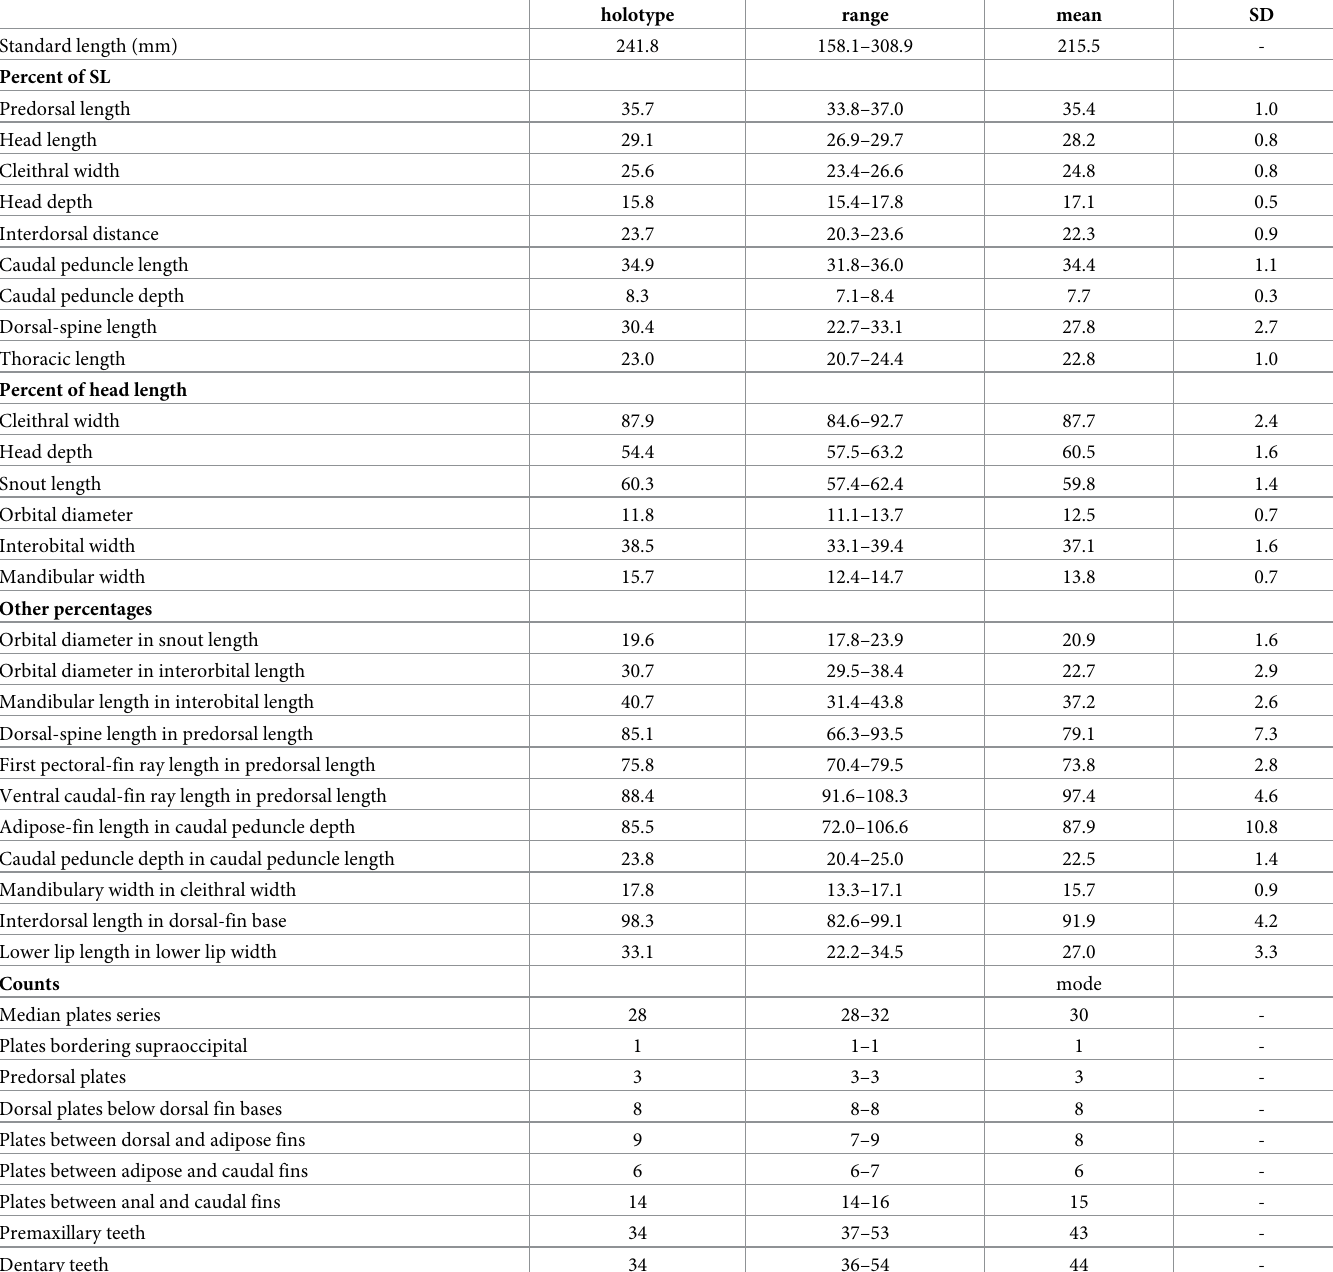
Table 1. Morphometric data of the holotype plus range, mean and standard deviation (SD) of 24 non-type specimens of Hypostomus subcarinatus